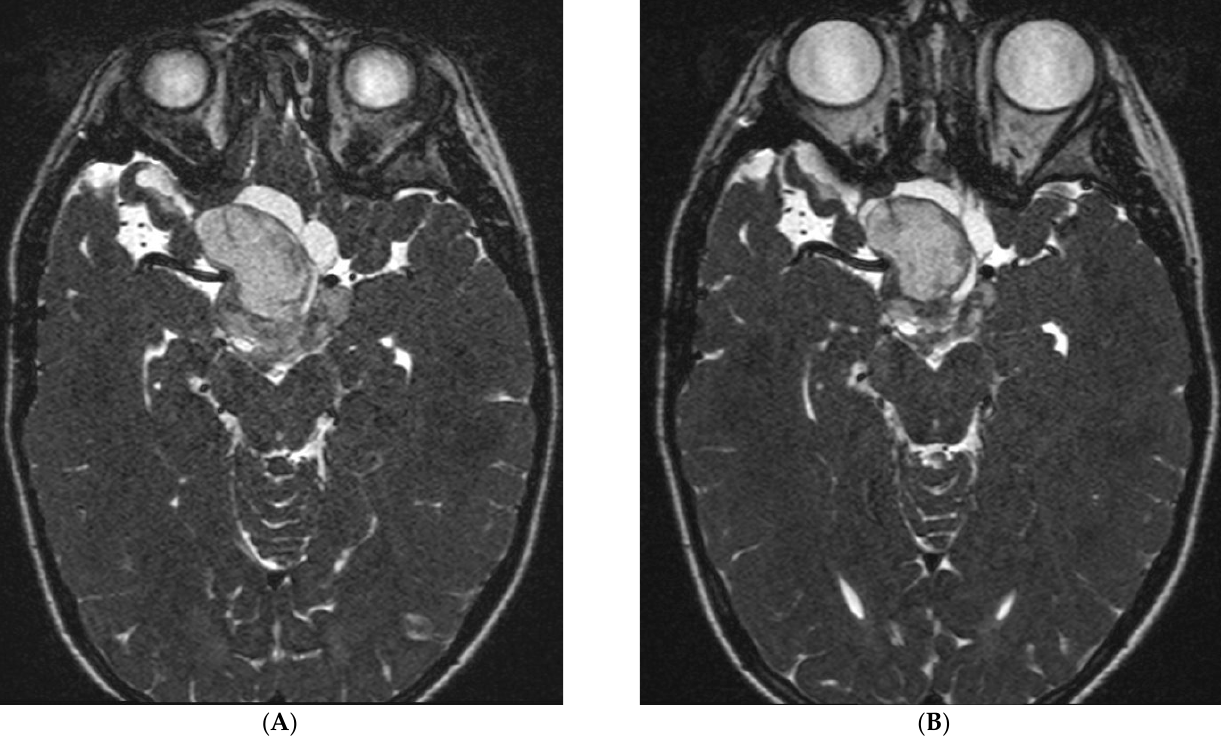
Figure 3. MRI (T2 gadolinium) of an LGG patient at inclusion ( A ) and 15 weeks later after 4 cycles of fluvastatin and celecoxib ( B ). This 8-year-old male patient experienced stable disease and remained on treatment for 23 cycles. A minor response, not meeting the RANO criteria, was observed when comparing the MRI at inclusion ( A ) with the MRI at week 15 ( B ).